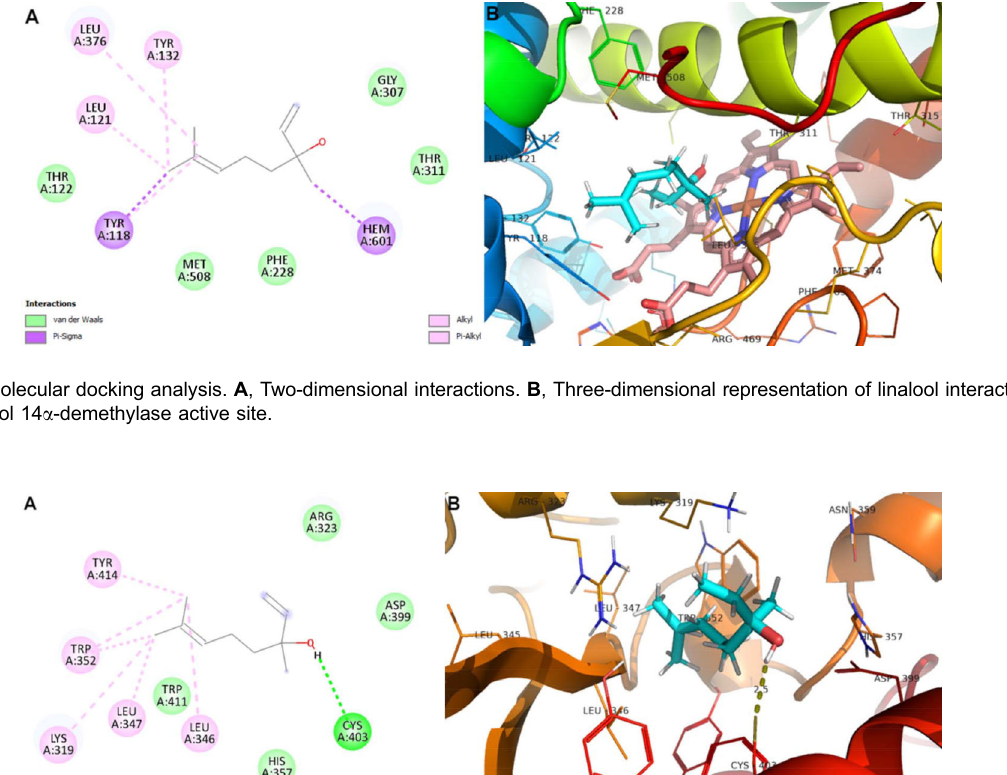
Braz J Med Biol Res | doi: